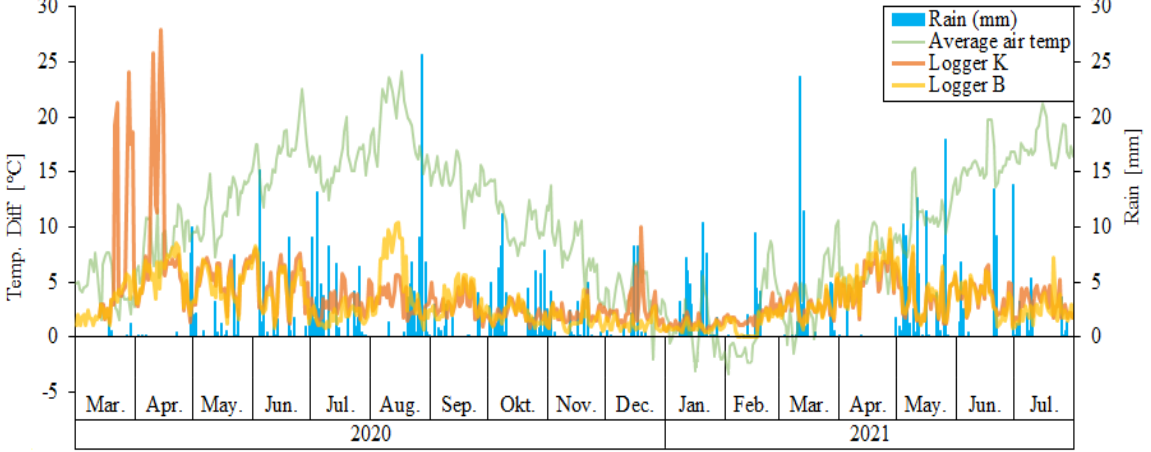
Figure 5. Difference between maximum and minimum water temperature [°C], rain [mm], and an average air temperature [°C] per day at station B (yellow) and station K (orange).